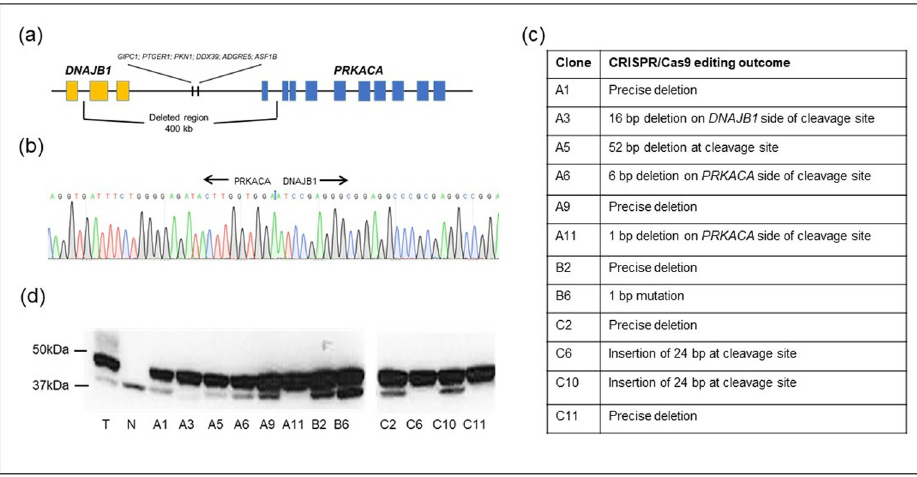
Fig 1. HEK-DP engineering. (a) Schematic of chromosome 19 400 kb pair deletion with (b) example of sequencing at the junction site between DNAJB1 and PRKACA . (c) Comparison of DNA sequence at junction site compared to expected sequence of 12 HEK-DP clones. (d) PKA-C α immunoblot analysis demonstrated DP fusion protein expression by a 46kD band and wild-type PKA-C α by a 41kD band. Patient FLC tumor sample (T) and normal